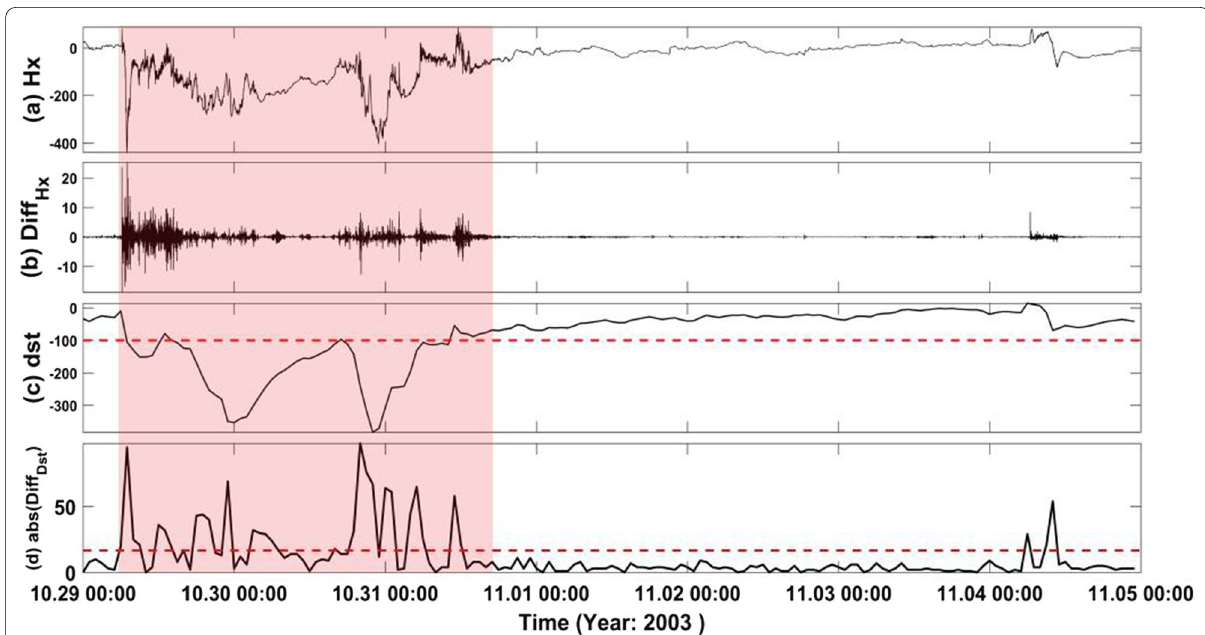
Fig. 3 Variations in the Hx component of site 163 and the Dst index. a Shows the variation in the Hx component. b Shows the first derivative of the Hx component. c Shows the variation in the Dst index. d Shows the first derivative of the Dst index’s absolute value; the red dashed line denotes 1.5 σ ( σ is the standard deviation). The horizontal axis denotes the time in UTC. The shadow in red represents the data in the storm